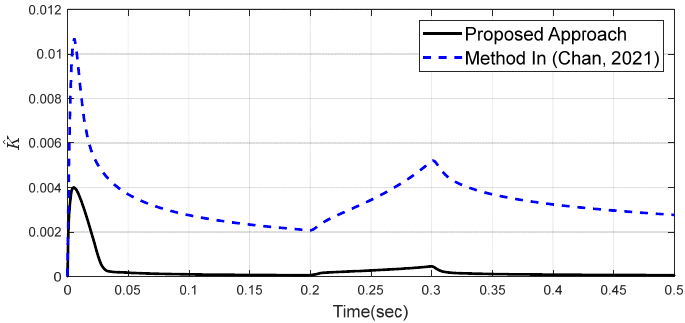
Figure 10. Adaptation gains [1] .